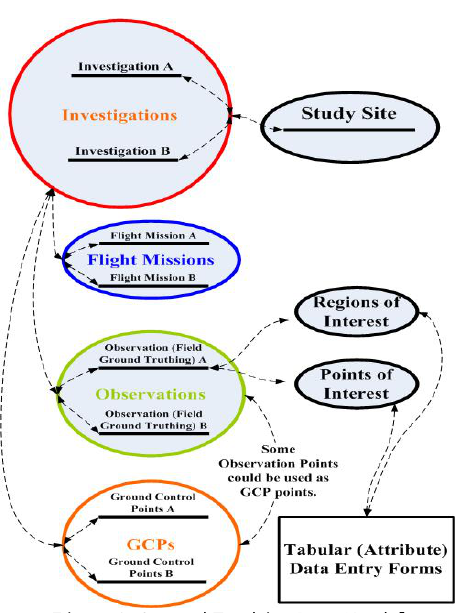
Figure 2. Ground Truthing Data